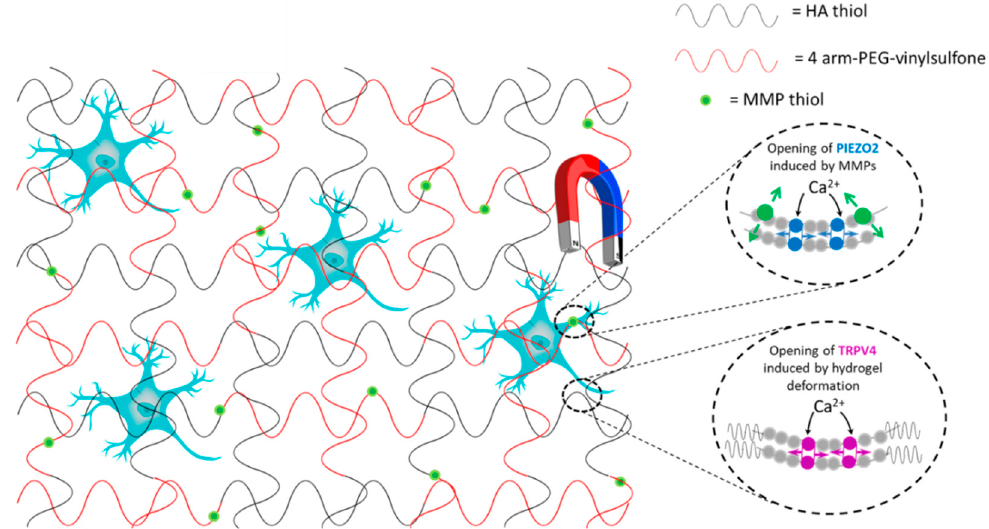
Figure 5. Schematic representation of the developed magnetic hydrogel based on 4-arm-PEG-vinylsulfone, HA and MMPs in [159] and of the magnetomechanical induced activation of Ca 2+ channels: PIEZO2 and TRPV4. PIEZO2 channels are activated by the membrane stretching upon MMPs stimulations and TRPV4 channels were activated by the subsequent hydrogel deformation.